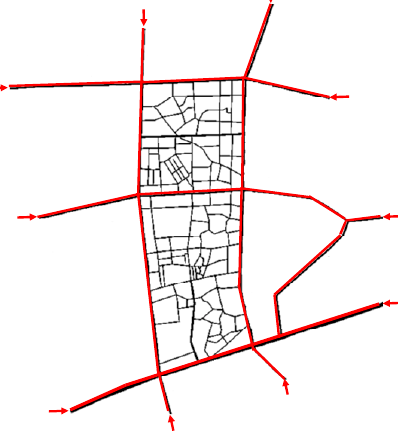
Figure 9. Road Figure 9. Road network.